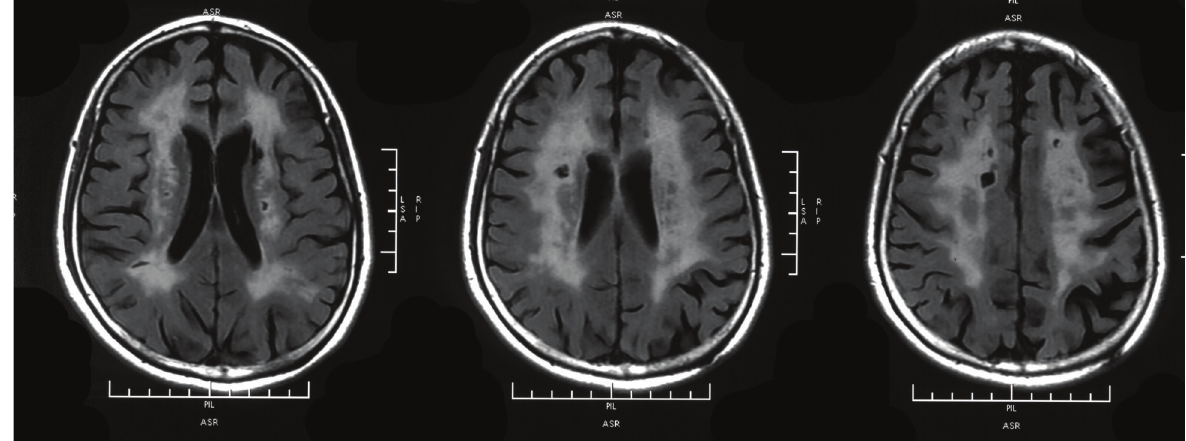
Figure 3. Head MRI and FLAIR images of III6. Image shows bilateral lateral ventricles, bilateral semi-oval center with multiple abnormal signals, and demyelination in the white matter around the bilateral lateral ventricles.